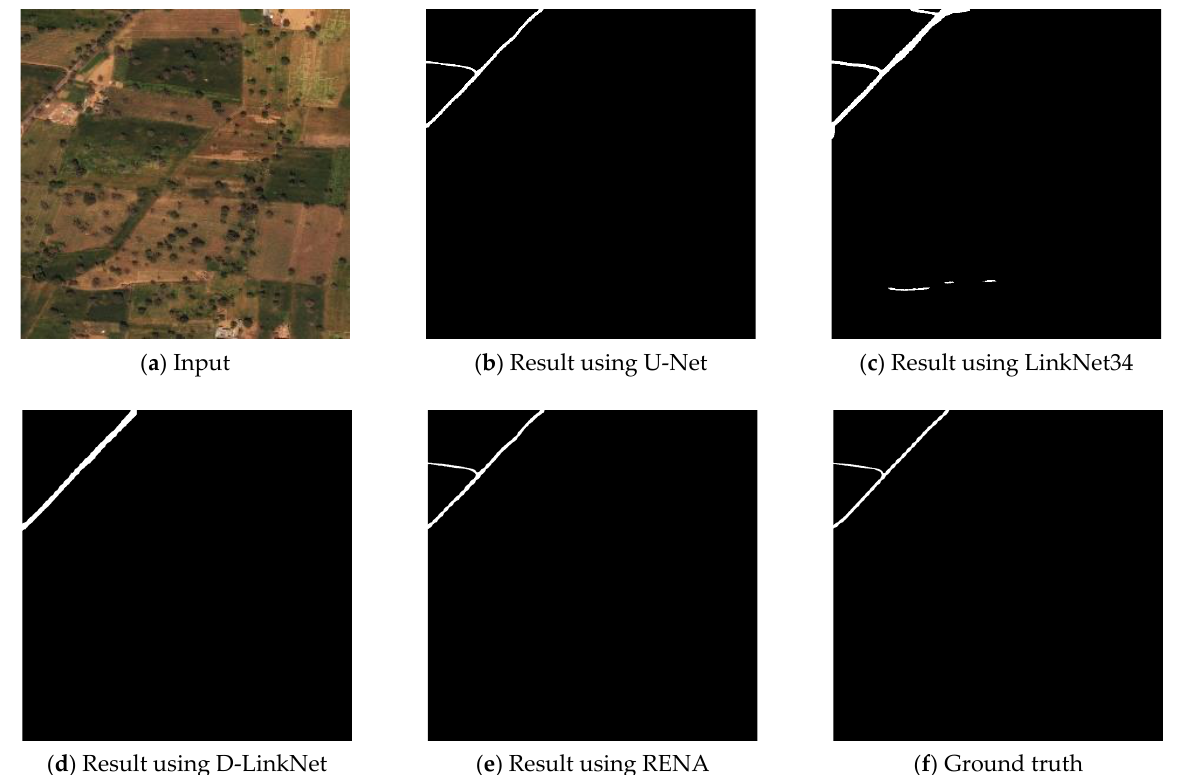
Figure 9. Visual evaluation results of the first group of sparse road networks.